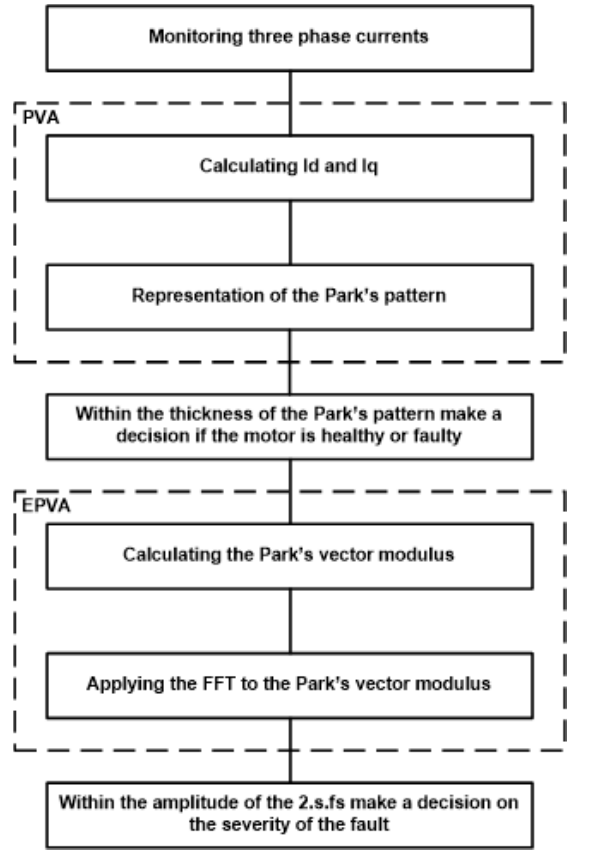
Figure 2. Proposed flow chart of the CPEPVA.